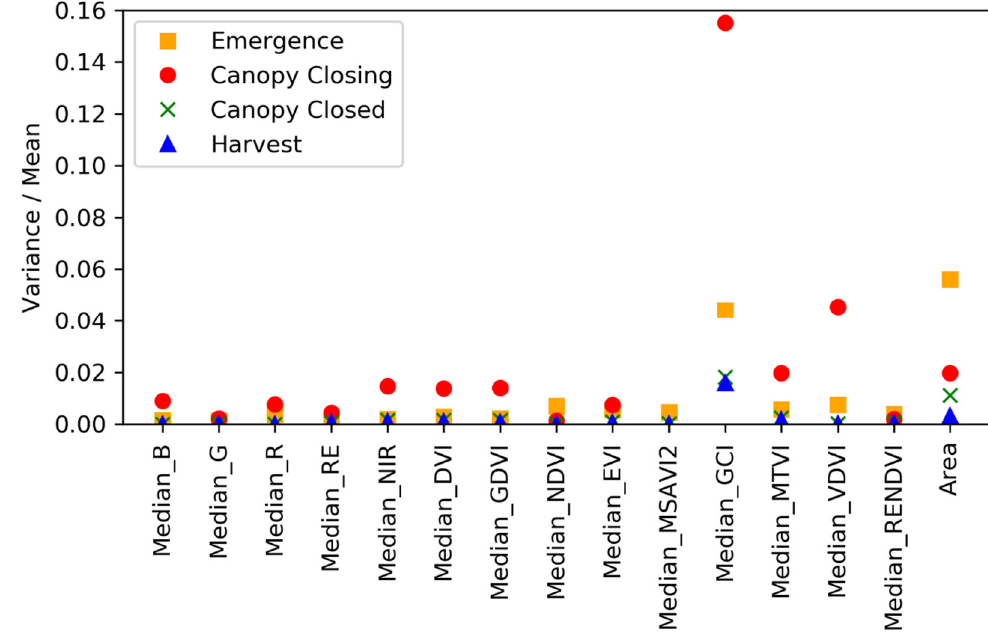
Figure 12. There was limited radiometric variability for each New York table beet growth stage in 2018. The cumulative experimental plot variance is divided by the mean of each radiometric feature and canopy area. The emergence and canopy closing growth stages exhibited the most variable features amongst the full set of plots, reinforcing the modeling results.